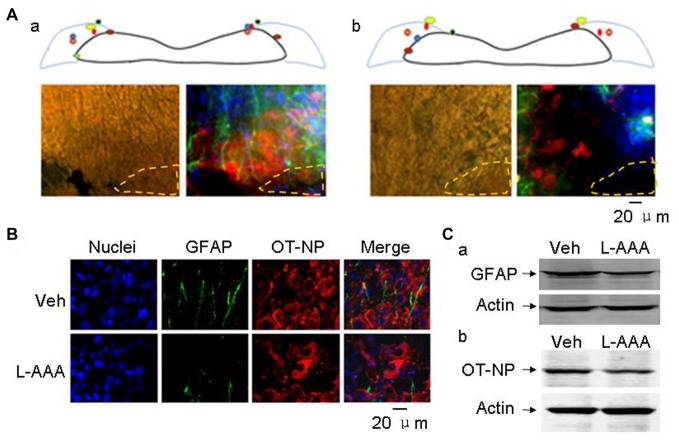
Effects of l-aminoadipic acid (L-AAA) on the expression of glial fibrillary acidic protein (GFAP) and OT-NP in the SON. (A) Central loci (upper panels, marked with colored dots) of intra-SON microinjection of aCSF (Aa, 2 μl) and L-AAA (Ab, 2 mM, 2 μl) containing 0.4% Trypan blue and their effects on GFAP and OT-NP in microscopic immunostaining images (lower panels), respectively. The images are present in bright field (left) and in merged images of nuclei (in blue), GFAP (in green) and OT-NP (in red). (B) Microscopic images showing immunostaining of nuclei (in blue), GFAP (in green), OT-NP (in red) and their merges without (top panels, vehicle, veh) and with (bottom panels) L-AAA treatment. (C) Western blotting bands showing GFAP (Ca) and OT-NP (Cb) expression in the SON without and with intranuclear L-AAA injection. Other annotations refer to Figure 3.